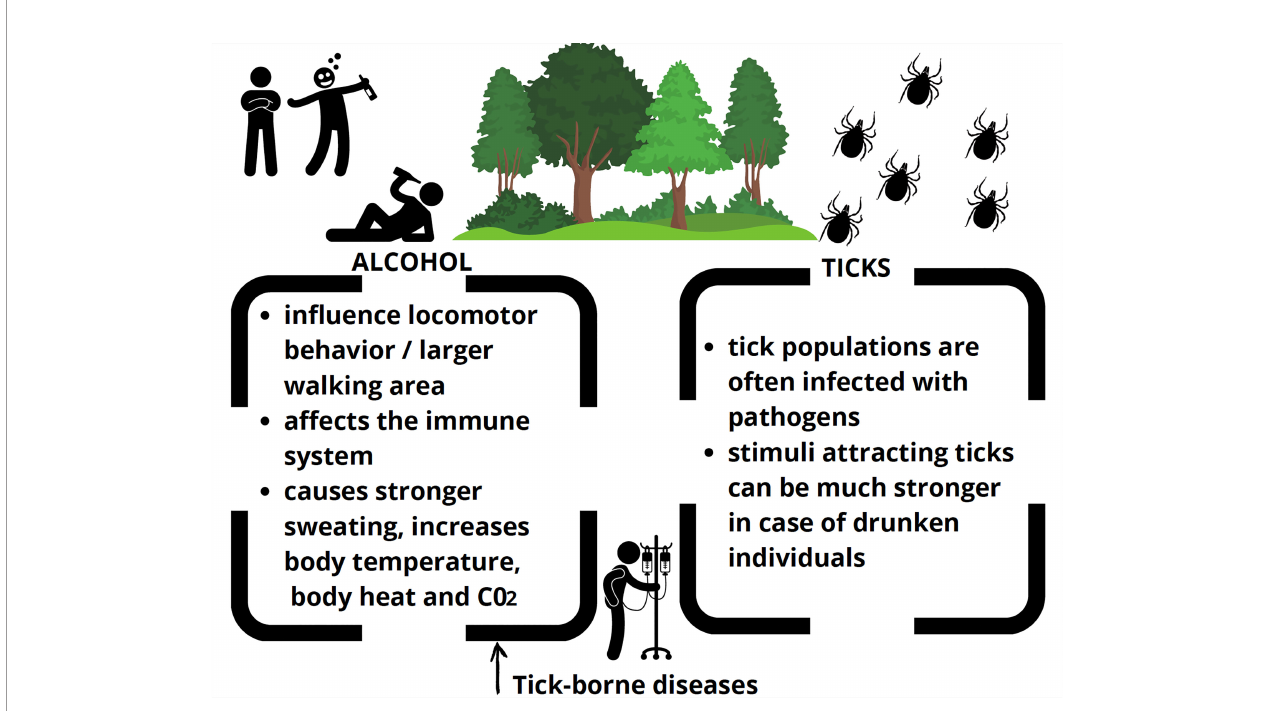
FIGURE 1 | Graphical summary of the ideas described in the